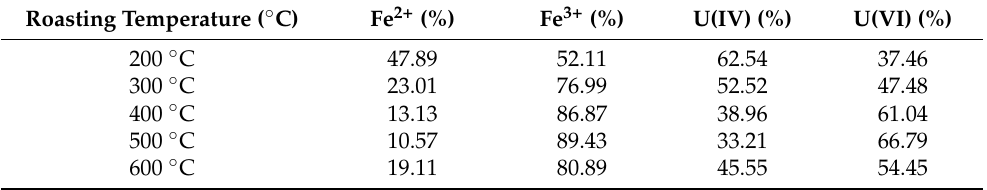
Table 8. XPS element analysis diagram of tantalum-niobium slag after roasting.